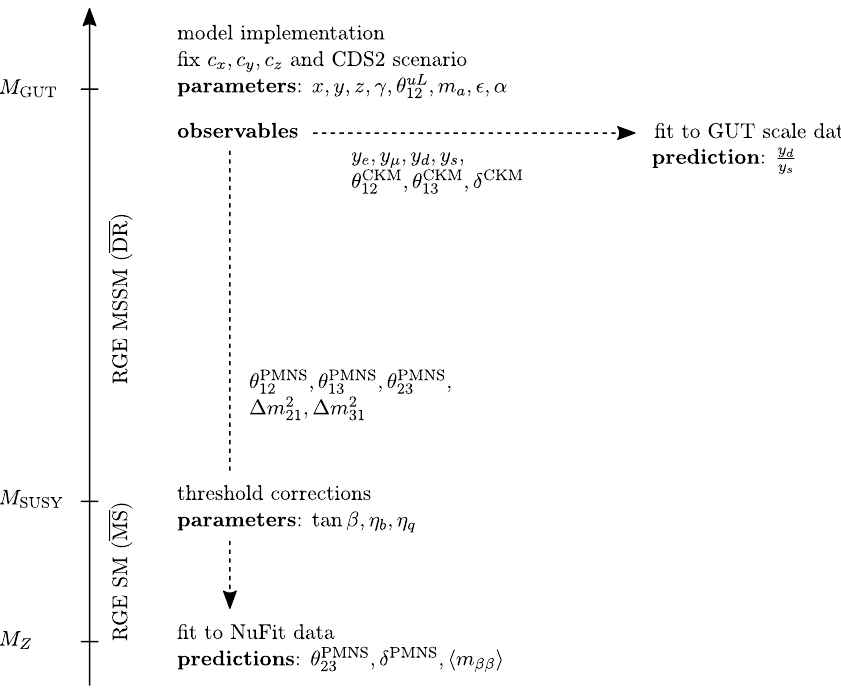
Figure 1 . Schematic illustration of the model quantities concerning the di(cid:11)erent mass scales. On the y-axis the three mass scales M GUT , M SUSY and M Z are indicated, as well as the type of the RGEs needed for the running. At M GUT the model is implemented by (cid:12)xing the CG coe(cid:14)cients, the CSD2 scenario and 8 of the model parameters. Then 7 observables corresponding to the Yukawa couplings and the CKM matrix are (cid:12)tted directly to the experimental values at the GUT scale using the data from [64]. The other 5 observables, corresponding to the neutrino masses and the PMNS matrix are run down to the Z scale, where they are (cid:12)tted to the data from NuFIT 3.2 (2018) [13]. At the SUSY scale, the threshold corrections are speci(cid:12)ed by 3 parameters and we also switch from the DR to the MS scheme when matching. While the Yukawa ratio of the down and the strange quark is predicted at M GUT , the other predictions are run down to M Z